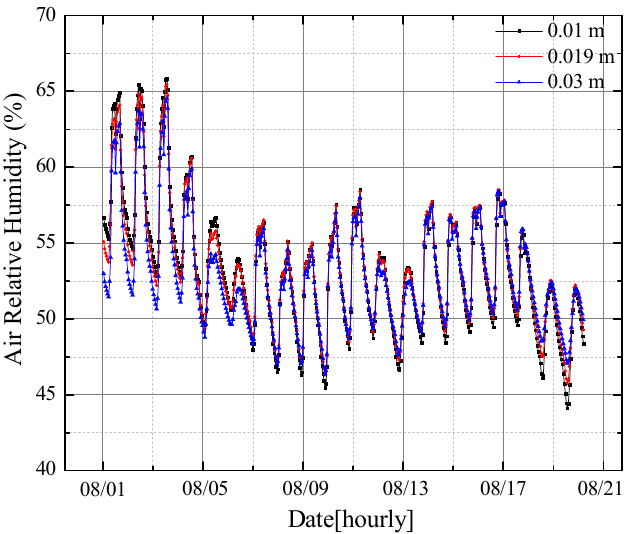
Figure 15. Relative humidity using different thickness of hygroscopic materials.